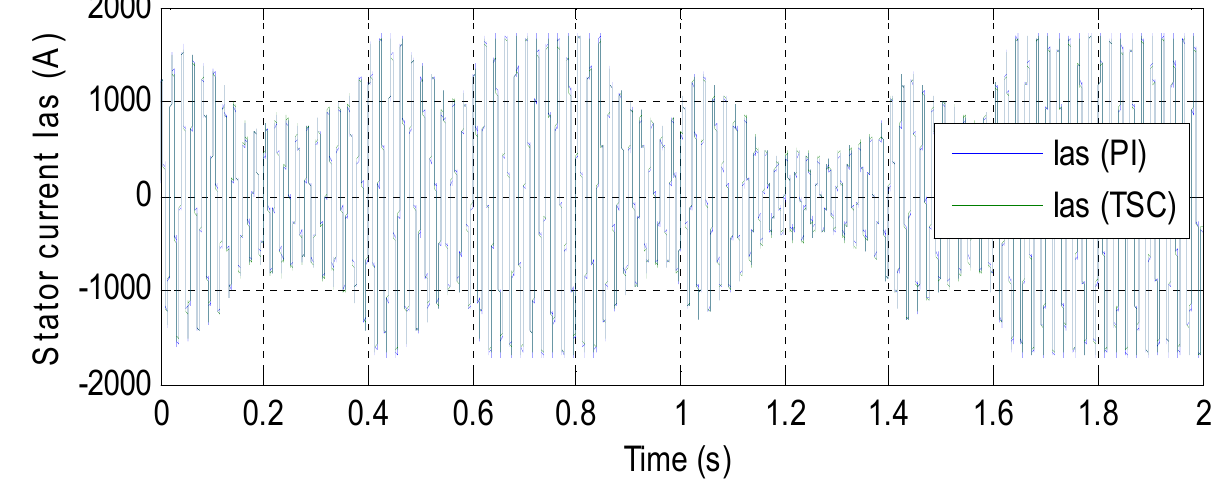
Figure 19. Torque. Figure 19. Torque.